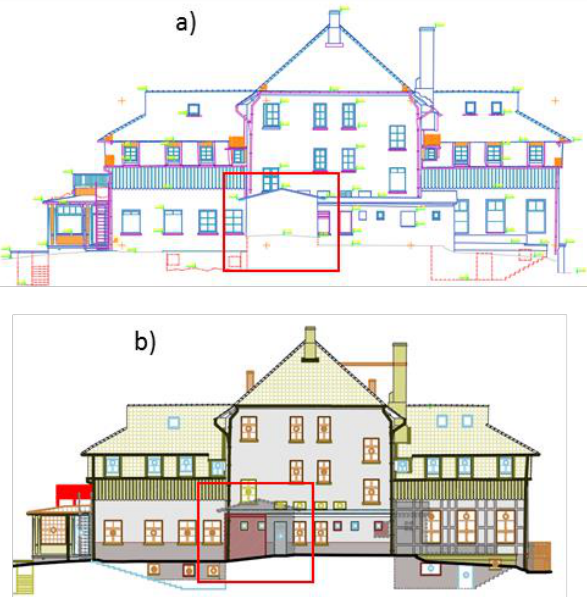
Figure 8. Eastern façade of the building a) surveyors 2D drafting; b) architects 2D drafting.